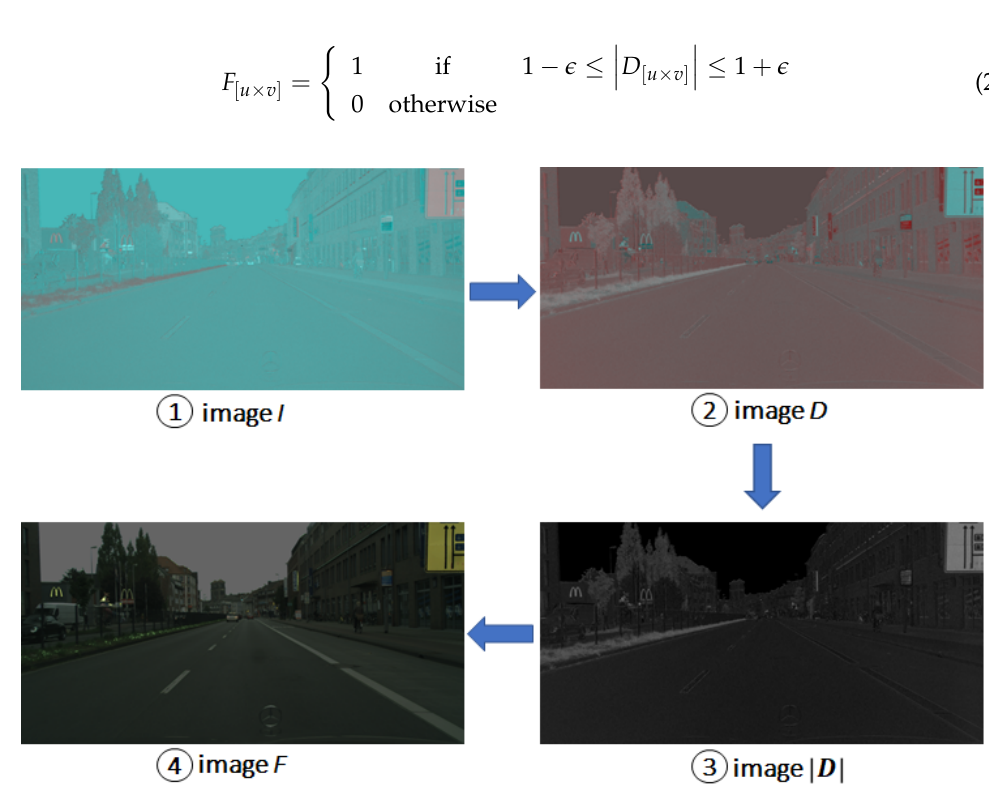
Figure 3. Complex division using a representative chromatic